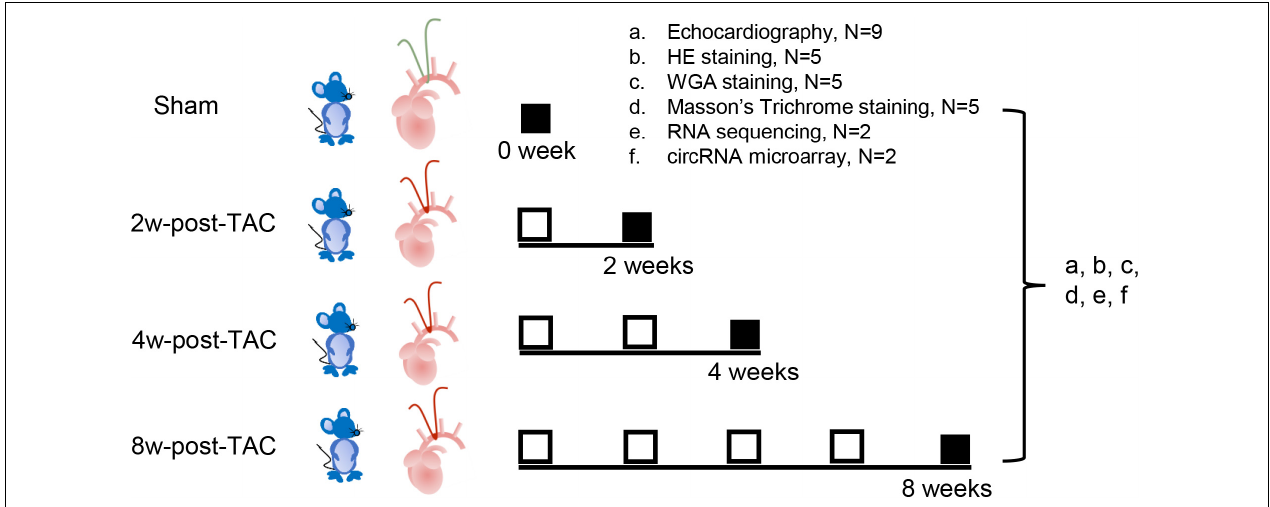
FIGURE 1 | Experimental design. Thirty-six C57BL/6J mice underwent transverse aortic constriction (TAC) surgery. Following 2-, 4-, and 8 weeks TAC stress, heart structure and function at each stage were assessed by echocardiography (a; N = 9/group), histology examination (b, HE staining; c, WGA staining; d, Masson’s trichrome staining; N = 5/group), RNA sequencing (e; N = 2/group), and circRNA microarray analyses (f; N =